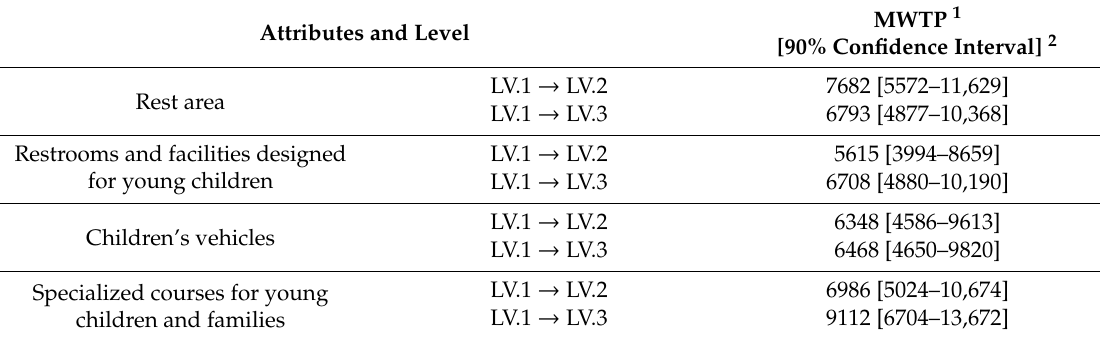
Table 4. Marginal willingness to pay (MWTP) estimation